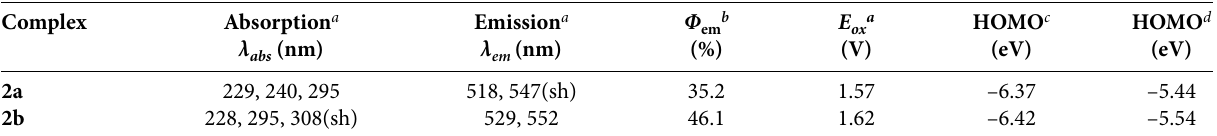
Table 2. Photophysical and electrochemical data of complexes 2a–2b . Complex